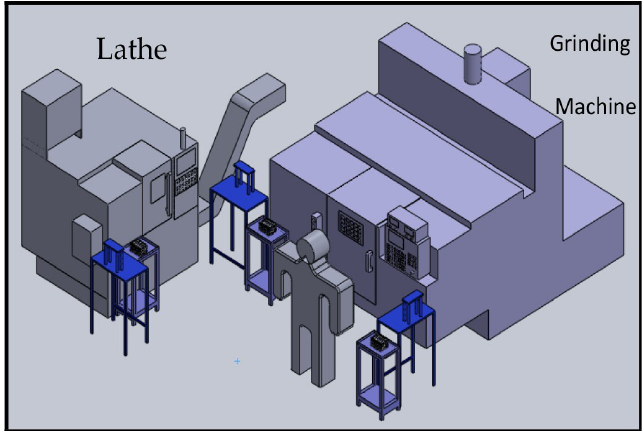
Figure 5. Distribution of the Cell in